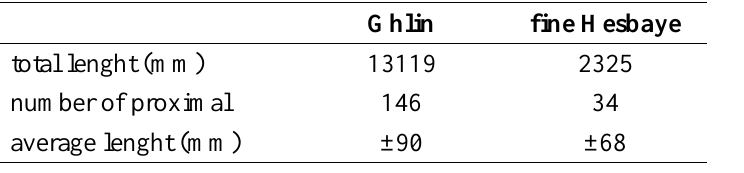
Table 3- Average lenght (in mm) of the blades in fine-grained flint of Hesbaye and in Ghlin flint. This average is calculating on the minimal number of blades which is obtained by the number of proximals.